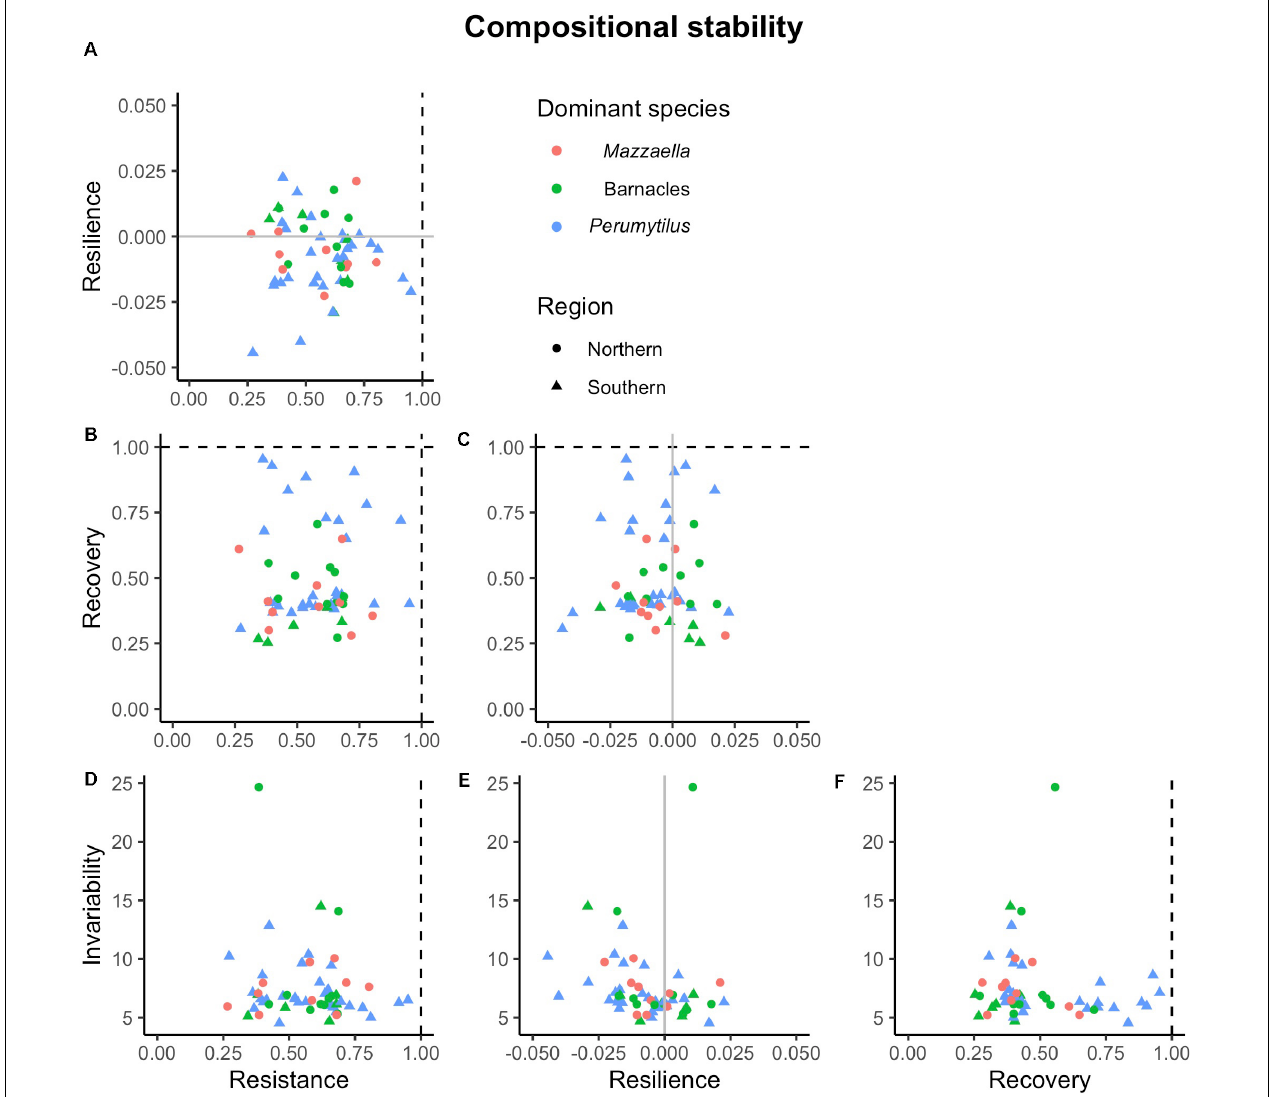
FIGURE 6 | Associations among four dimensions of compositional stability. All pairwise combination were analyzed: resilience against (A) resistance; recovery against (B) resistance and (C) resilience; and invariability against (D) resistance, (E) resilience, and (F) recovery. Dashed lines represent maximum resistance and recovery; solid gray lines represent minimum resilience. No statistically significant correlation was detected across